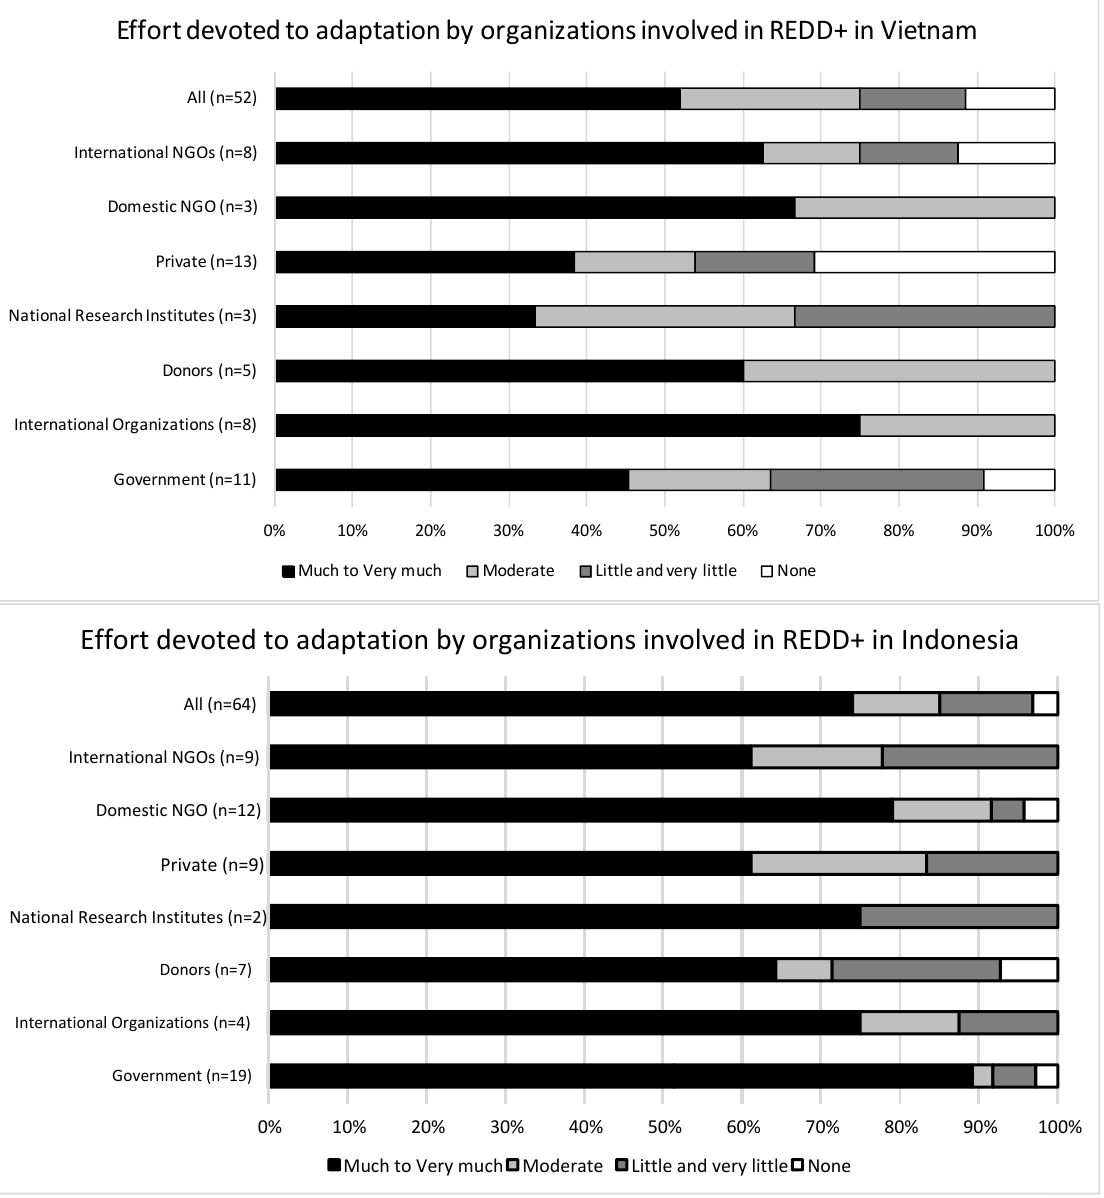
Figure 1. Level of effort directed toward climate change adaptation by organizations involved in Reducing Emissions from Deforestation and forest Degradation (REDD+) in Vietnam and